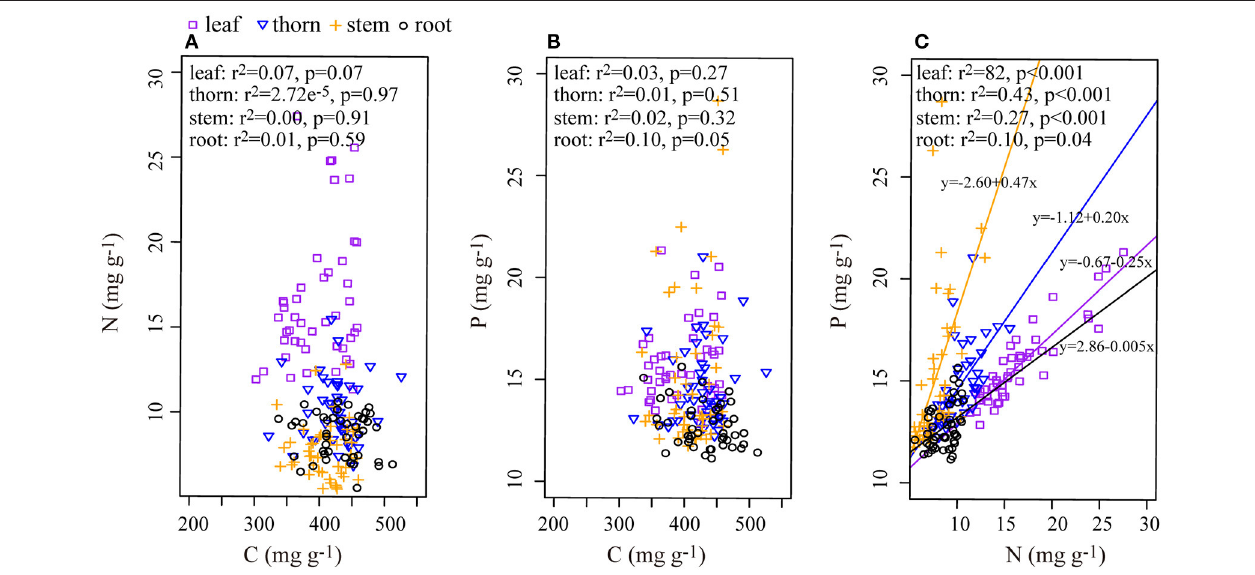
FIGURE 2 | Relationship among C, N, and P in the leaf, thorn, stem, and root organs of Alhagi sparsifolia . (A) The relationship between C and N; (B) the relationship between C and P; (C) the relationship between N and P. Regression lines are shown only for relationships that were significant at p < 0.05.